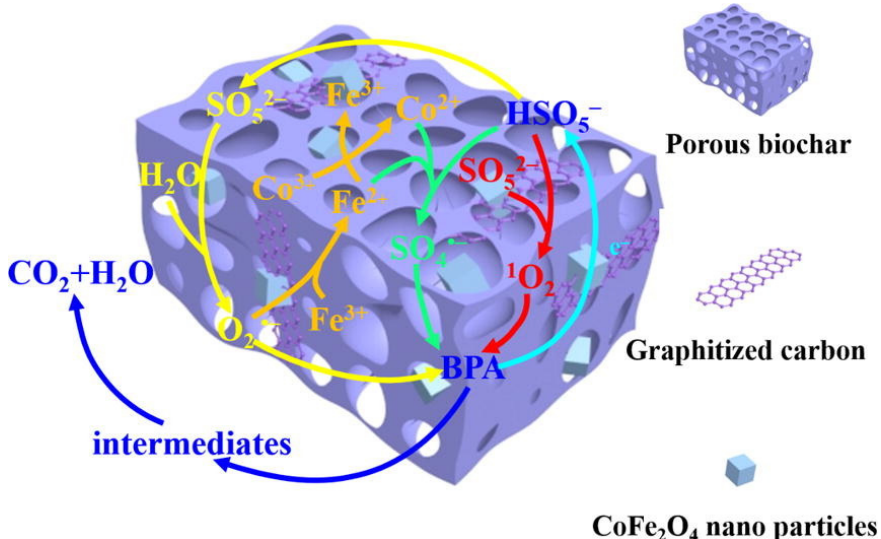
Figure 10. General scheme for the interactions between CoFe 2 O 4 nanoparticles on graphene-like biochar for the activation of PMS for the degradation of bisphenol A. Reprinted from Liu et al. [178] with permission of Elsevier.